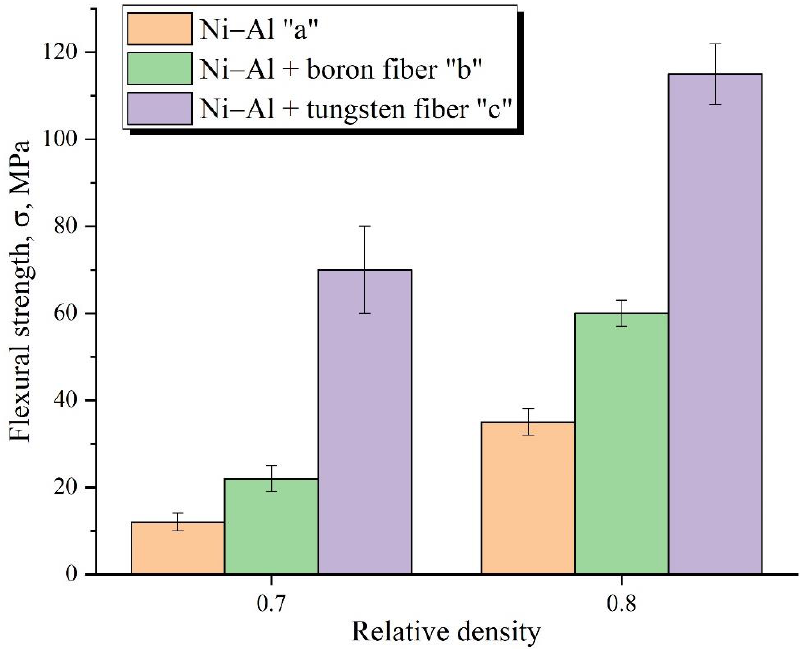
Figure 7. Flexural strength of specimens with different reinforcements.